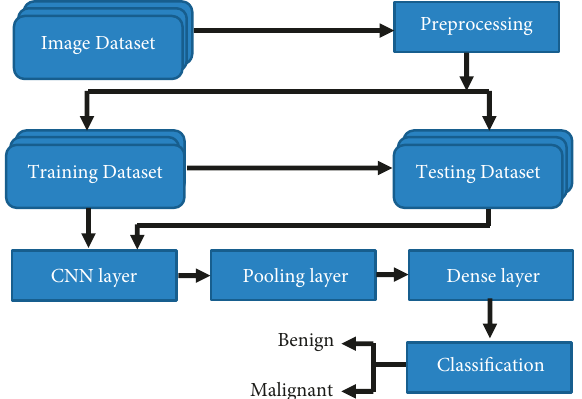
Figure 2: Basic CNN proposed model.